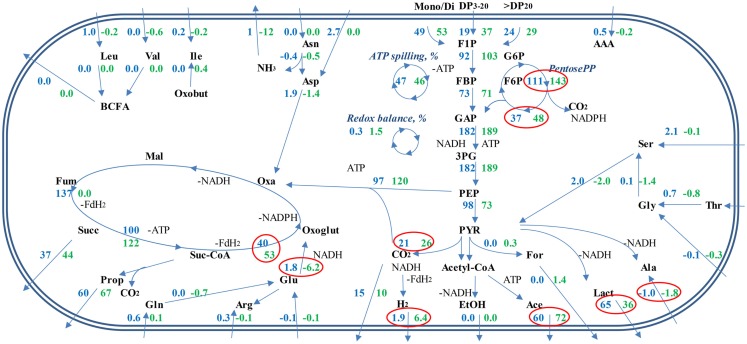
Proposed metabolic fluxes in B. thetaiotaomicron DSM 2079 grown in defined media. Average combined fluxes on levan, FOSmix, sucrose, and fructose in M20 medium (blue numbers), and M2 medium (green numbers). Significantly different fluxes (p < 0.05) at growth on M20 and M2 media are surrounded with red circles. Relative ATP spilling (%) shows the amount of ATP from total ATP produced not used for substrate transport, biomonomer synthesis, and polymerization of macromolecules. Relative redox balance (%) illustrates the amount of oxidized redox equivalents from total produced not regenerated through formation of measured fermentation end-products. Mono/Di means the sum of mono- and disaccharides (fructose, glucose, sucrose). DP is the degree of polymerization for oligo- and polysaccharides.